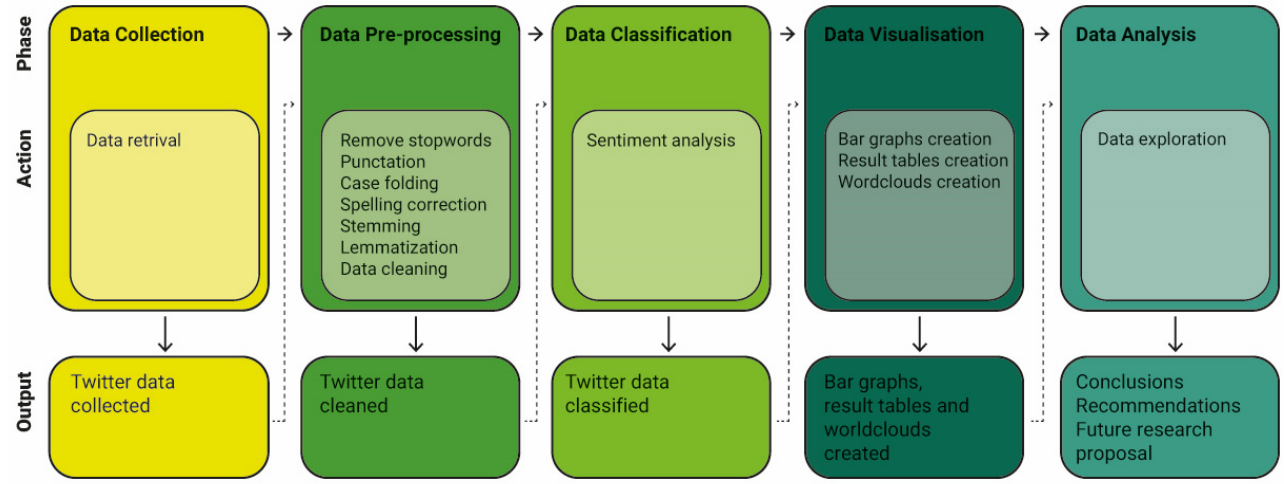
Figure 1. Flowchart of research